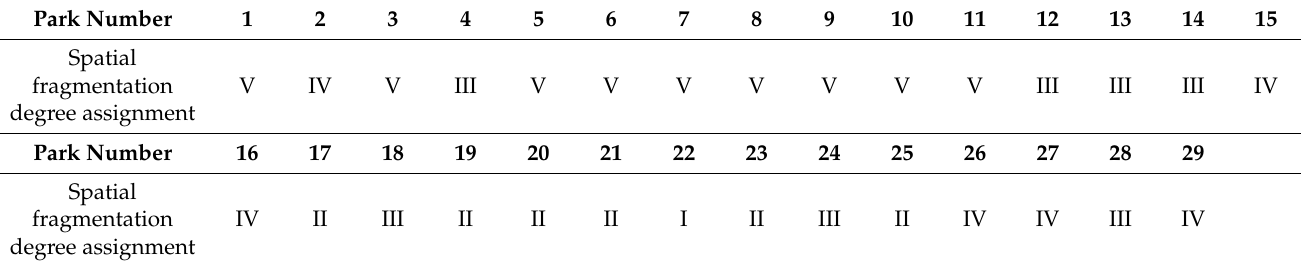
Table 10. The results of spatial fragmentation degree assignment of country